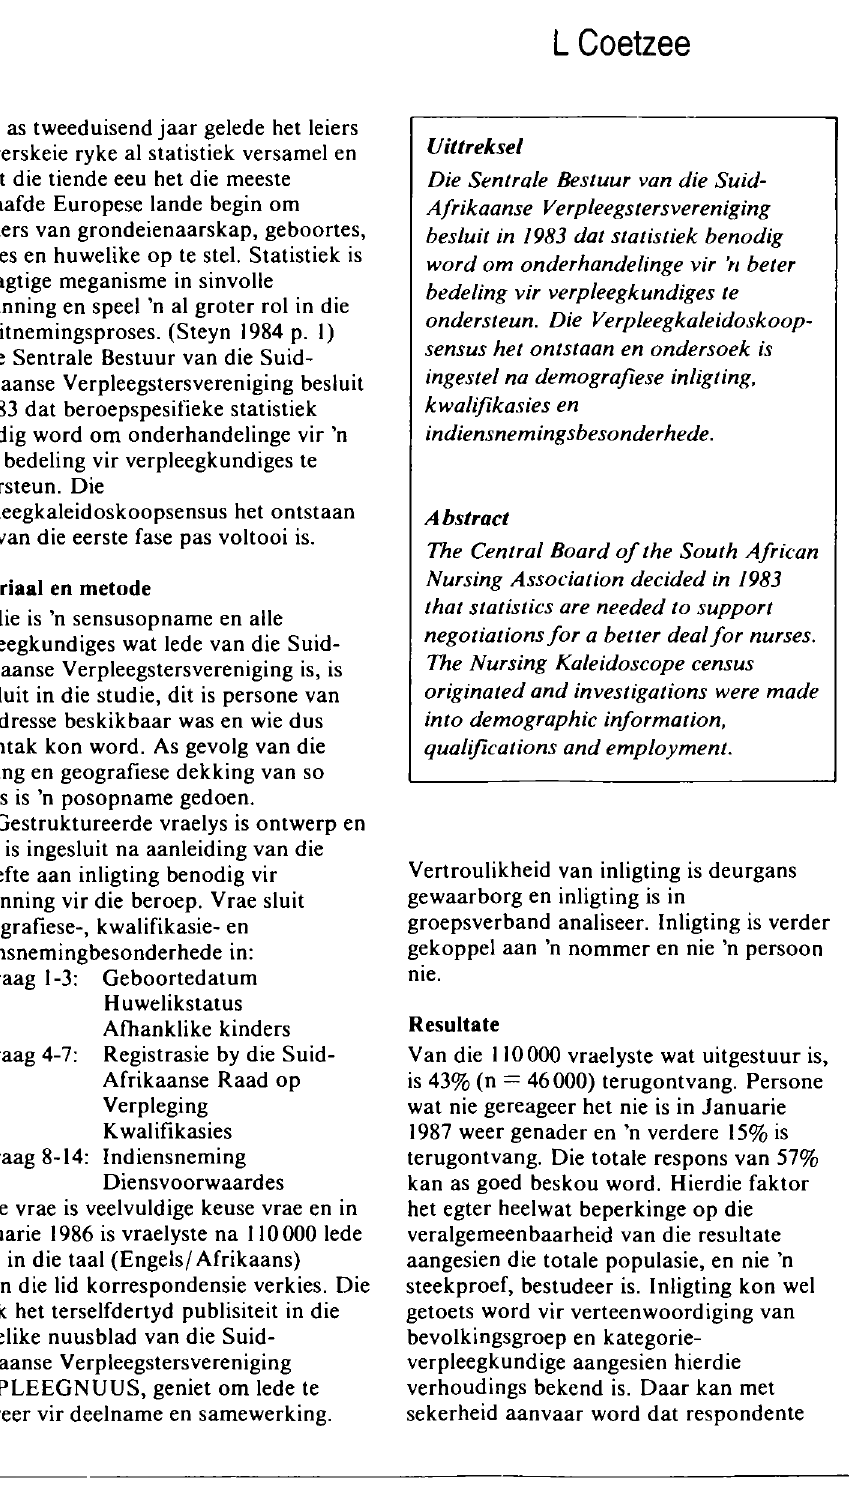
TABLE 1. SOUTH AFRICAN NURSING ASSOCIATION REGIONAL DISTRIBUTION ALL NURSES (1 October 1987: Region 0 and students excluded)